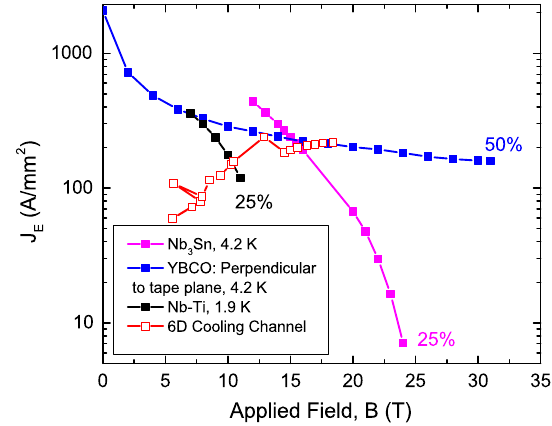
FIG. 9. Engineering critical current densities vs applied mag- netic fields for various conductors from published data [28]. The red line plots the required fields and current densities of a tapered muon cooling channel. Note that the current densities of the proposed channel are within the critical